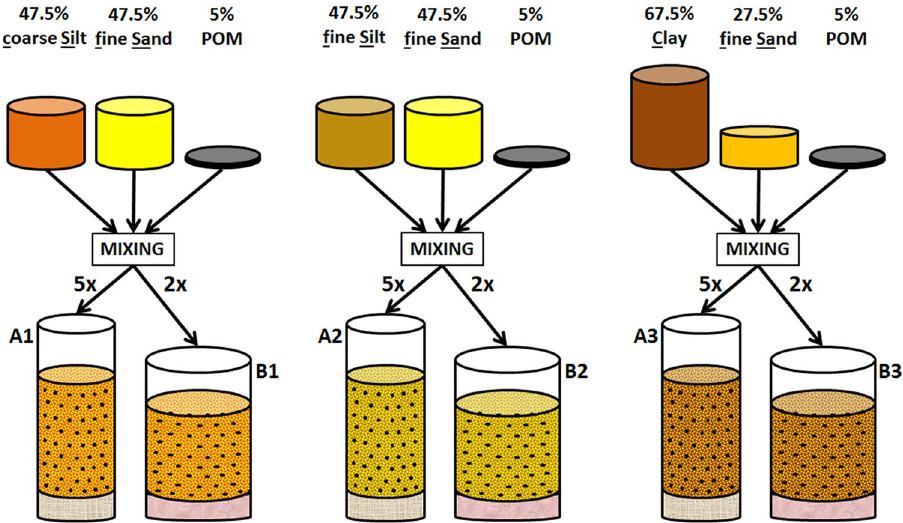
Figure 1. Schematic overview of soil sample preparation for staining experiments. Three series of five soil samples were constructed in micro-barrier sealed plastic tips (A1-3) containing a 0.45 µm nylon filter (grey layer). Each series consisted of 5% (mass) POM combined with a different mineral mixture. Four samples of each series were stained with a different staining agent (i.e. silver nitrate [AgNO 3 ], lead nitrate [Pb(NO 3 ) 2 ], lead acetate [PbAc] and phosphomolybdenic acid [PMA]), and one with deionized water (unstained control). Three identical series of two soil samples (B1-3) were constructed in centrifuge tube filter inserts, provided with a 0.22 µm pore diameter filter (pink layer). One sample of each series was stained with OsO 4 , the second sample of each series functioned as unstained